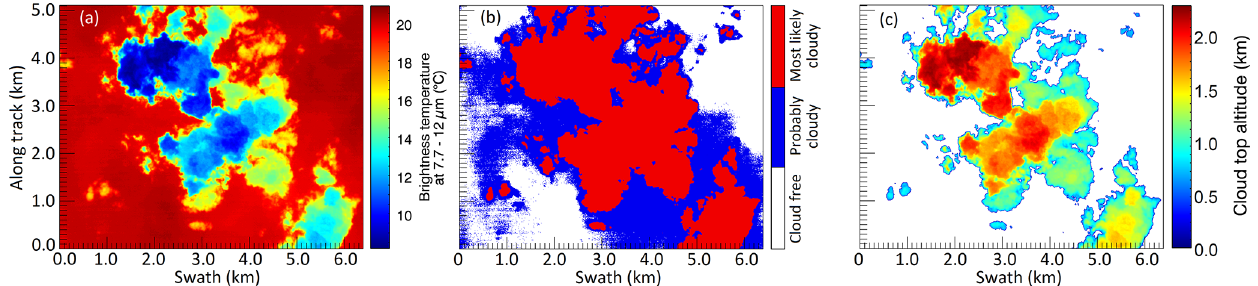
Figure 11. (a) The 2D field of brightness temperature measured at a flight altitude of approximately 10km with the VELOX broadband channel between 7.7 and 12µm during the EUREC 4 A field campaign on 9 February 2020 at 15:05:21UTC. For the same scene, panel (b) shows the combined cloud mask and panel (c) the retrieved cloud top